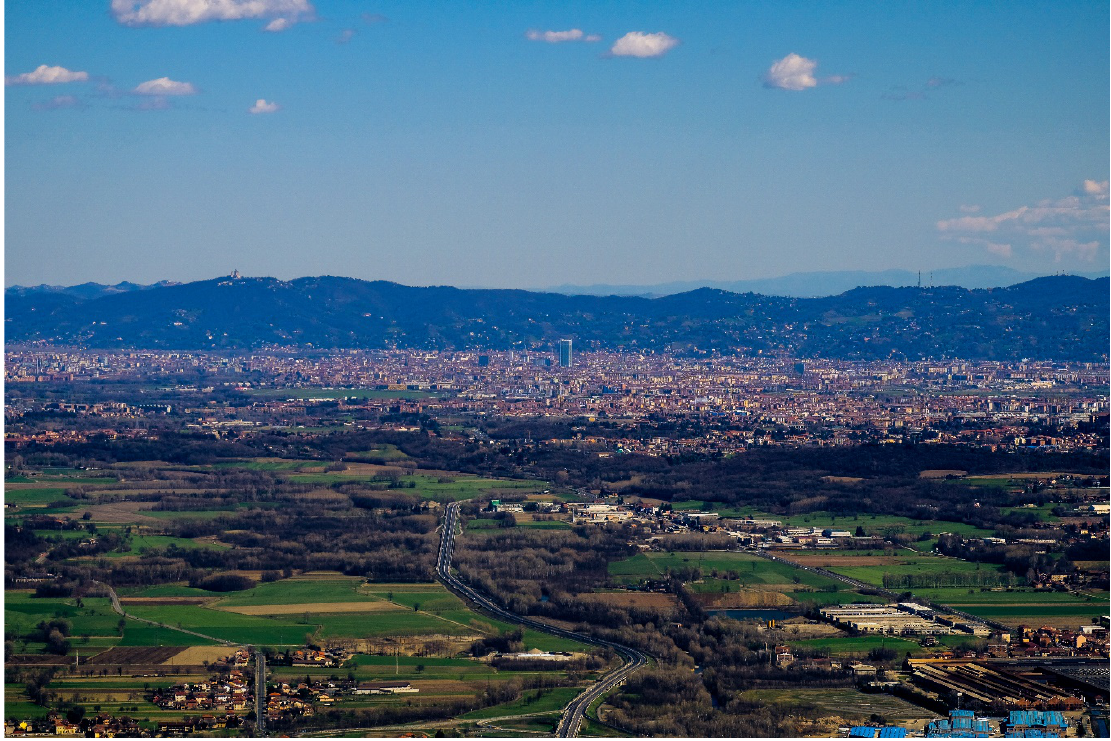
Figure 1. The TPA from panoramic points at the Sacra di San Michele (Photo: Mauro Volpiano).